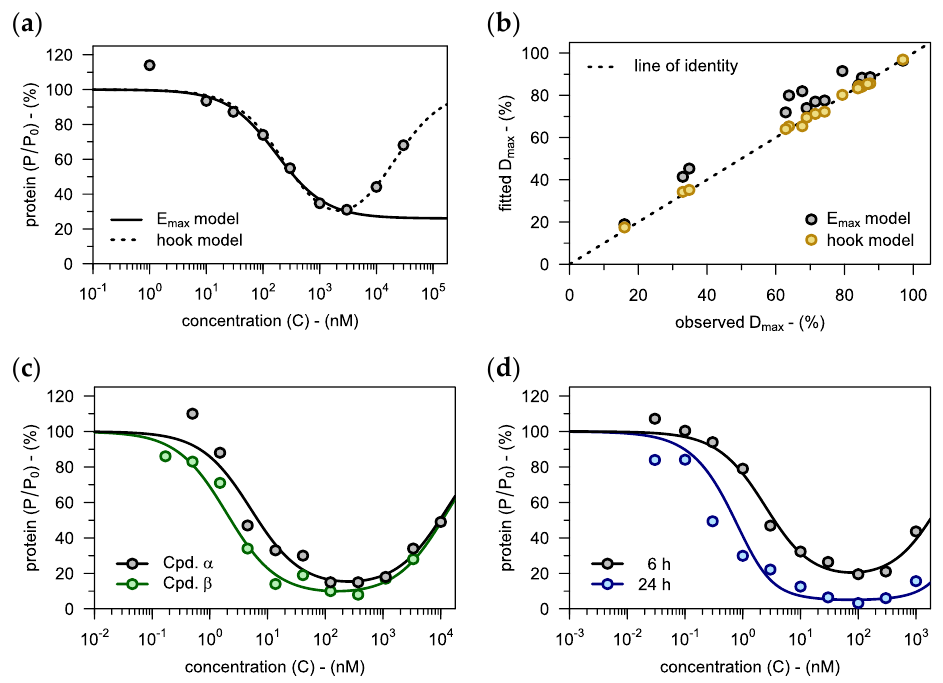
Figure 3. ( a ) Relative levels of target protein are plotted against PROTAC concentration in media (i.e., concentration-degradation profile). For comparison, both the hook model presented here as well as the conventional E max model are fitted to the data (see Figures S1 and S2 for further examples). When fitting the E max model, only concentrations below the concentration of maximal degradation were considered. ( b ) A total of 17 concentration-degradation profiles were described using both the hook model and the E max model. The resulting estimates for the maximal extent of degradation ( D max ) are plotted against the respective experimentally observed values. Experimental data ( a , b ) taken from Zorba et al. [21]. ( c ) The hook model is applied to reversible covalent ( Cpd. α ) and irreversible covalent PROTACs ( Cpd. β ). Data taken from Gabizon et al. [22]. ( d ) Protein levels after 6 h of incubation as well as levels after 24 h are plotted against the concentration of the non-covalent PROTAC Cpd. Y . The extended hook model (Equation (14)) is fitted to the concentration-degradation data from the 6 h time point, which then allows to predict degradation after 24 h. The experimental observations for the 24 h time point confirm that prediction. Data taken from Mares et al. [23].